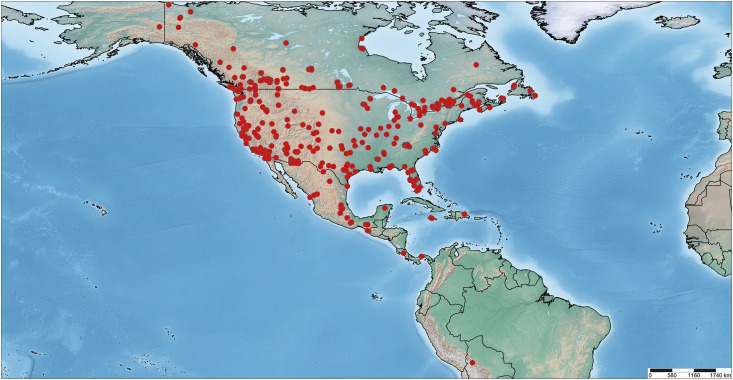
Distribution map of specimens of Pyraustinae sampled in this study with geocoordinates (n = 1461).